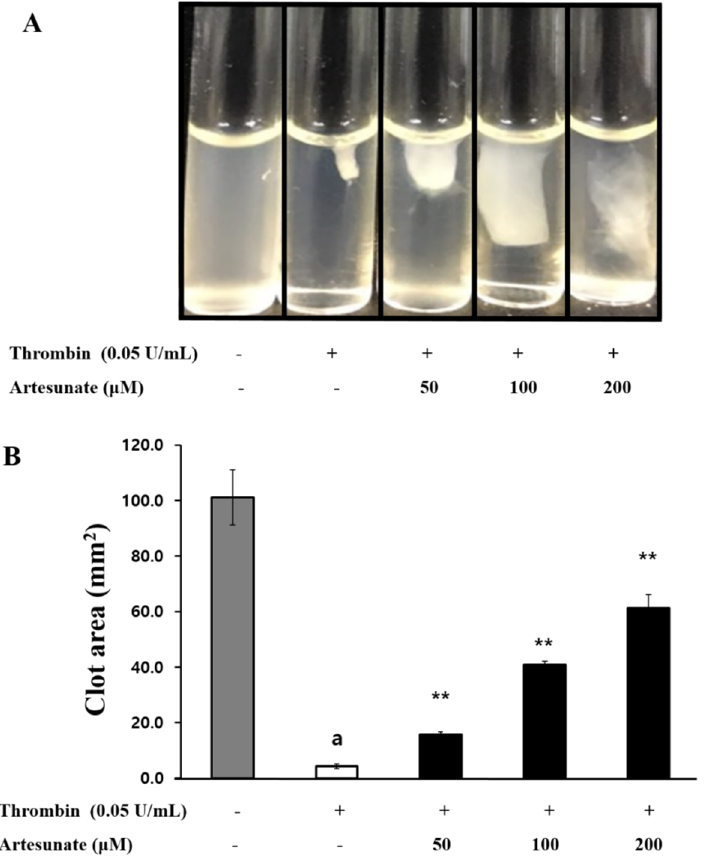
Figure 8. Artesunate’s effect on platelet-mediated fibrin clot retraction. ( A ) Artesunate’s effect on thrombin-retracted fibrin clot photographs. ( B ) Artesunate’s effect on thrombin-retracted fibrin clot area. To avoid sticking, a polyethylene tube contained the PRP (500 µL) and further stimulated via thrombin (0.05 U/mL) and 2 mM CaCl 2 at a temperature of 37 °C and a time of 15 min. A digital camera then took photographs of the platelets-mediated fibrin clots. The results are shown as mean ± SD ( n = 4). a p < 0.05 in comparison to non − stimulated platelets, * p < 0.05, ** p < 0.001 in comparison to the thrombin − induced